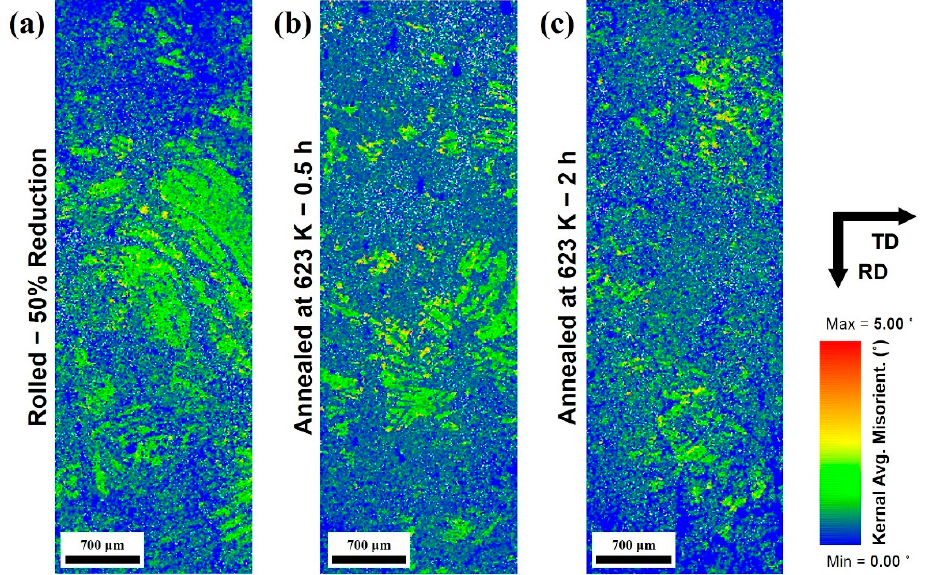
Figure 11. Kernal average misorientation (KAM) maps of the ( a ) rolled with 50% reduction and annealed at 623 K for ( b ) 0.5 and ( c ) 2 h.